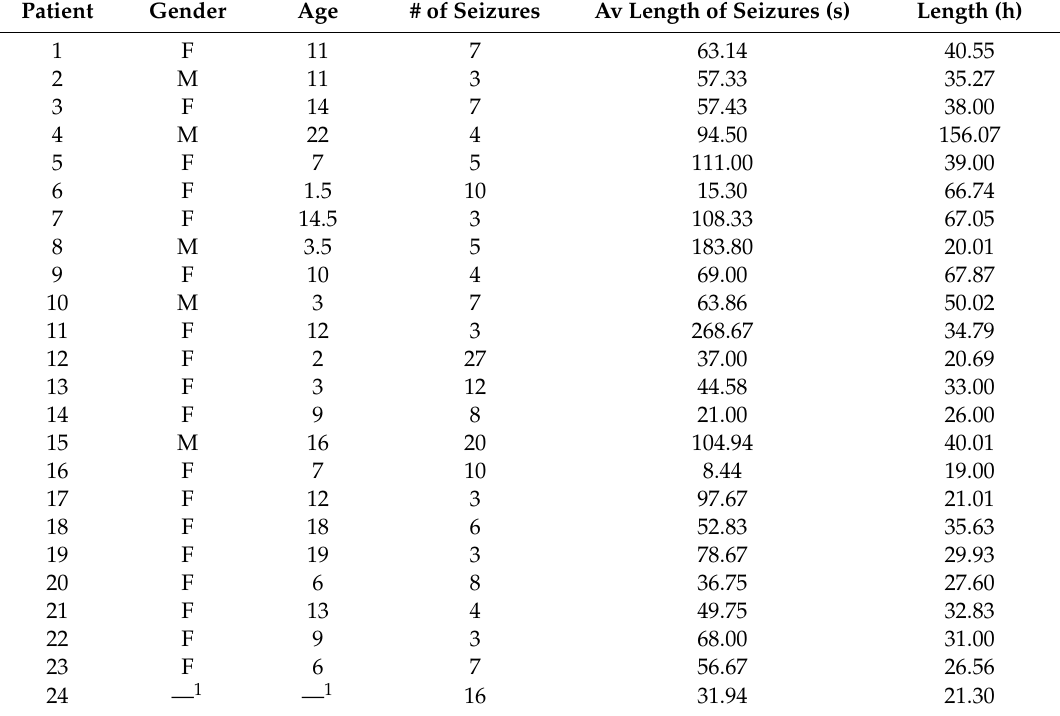
Table 2. Children’s Hospital Boston (CHB-MIT) patients record